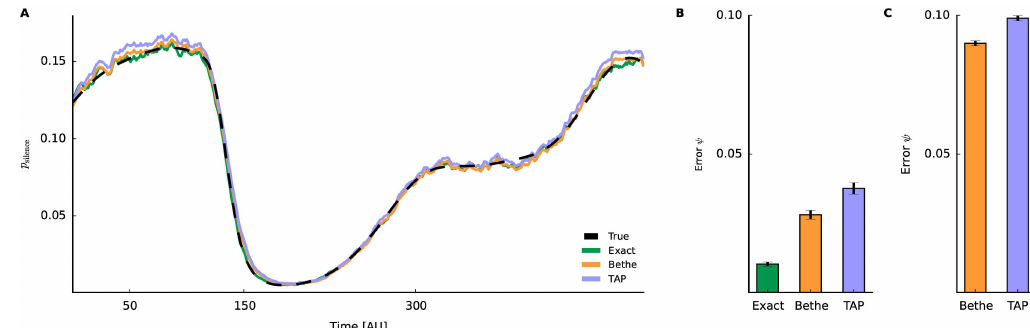
Fig 4. Time-varying probability of simultaneous silence. Results of different approximation methods. The underlyingmodel parameters are the same as in Fig 3. A The probabilityof simultaneous silence( p silence ( t ) = exp( − ψ t )) for a network of 15 neuronsas a function of time. The pseudolikelihood-Bethe (orange) and pseudolikelihood-TAP (lavender)method estimate the underlyingvalue with sufficient accuracy(dashedblack). For comparison, an estimate by the exact method (green)is shown. B The error between the approximate and true free energy ψ t . C The error of free energy ψ t for large networks ( N = 60, data same as in Fig 3 C